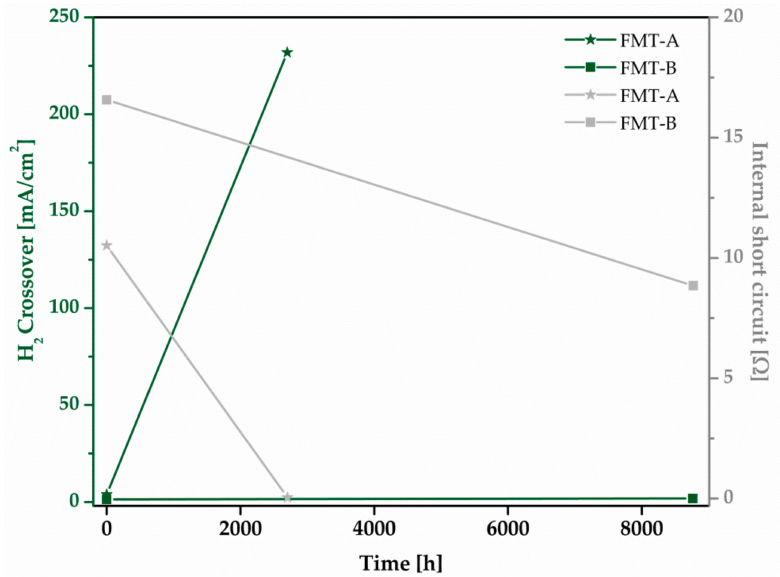
Figure 6. H 2 crossover and internal short circuit of FMT-A and FMT-B calculated from LSV measurements, BoL, and EoL /